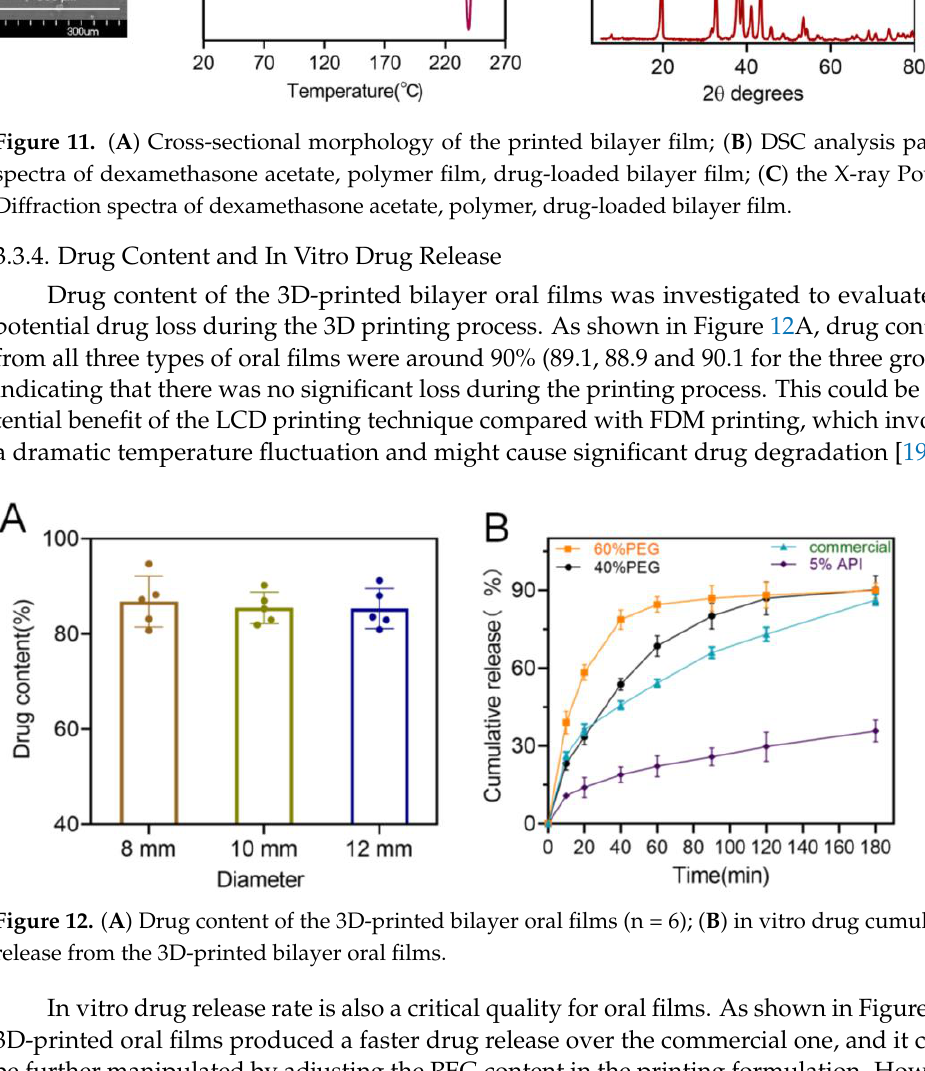
release from the 3D-printed bilayer oral films.